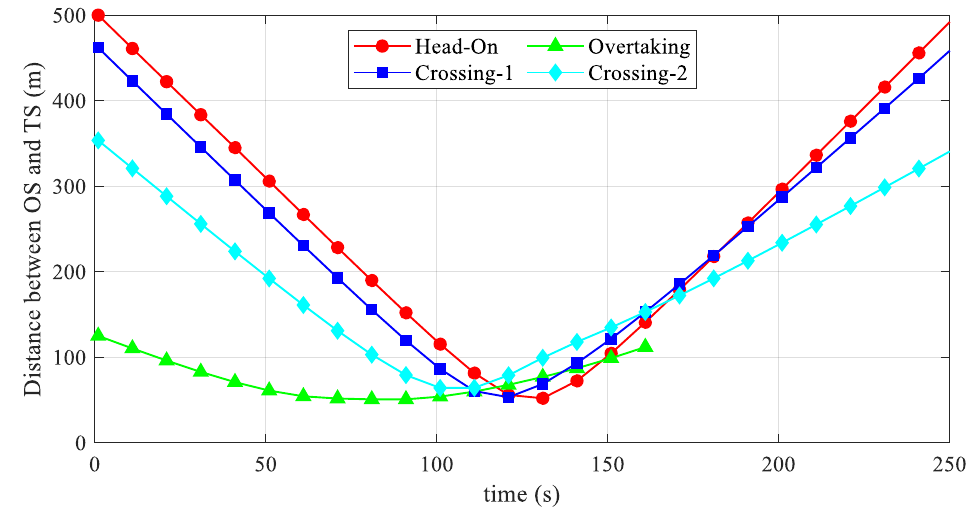
Figure 7. The relative distances between OS and TSs in the single dynamic obstacle scenario.